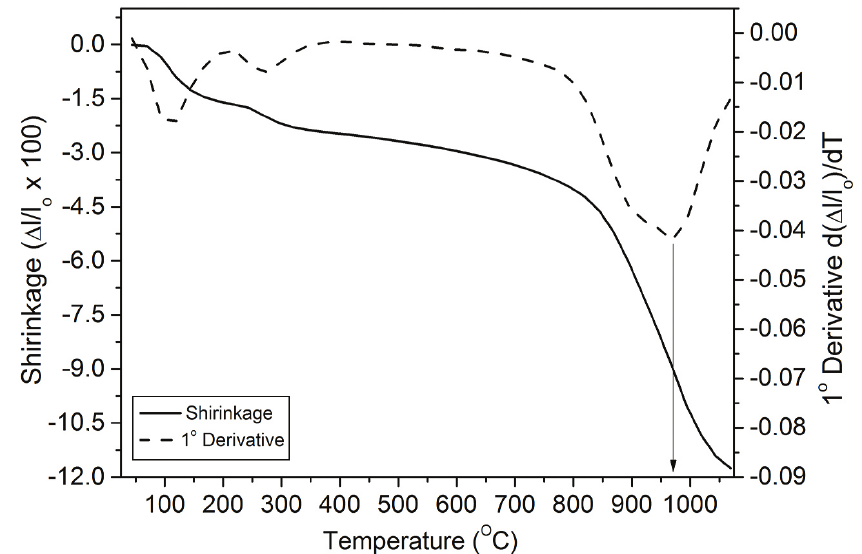
Figure 3. Dilatometric analysis of a green disk-shape of BSCF synthesized powder.